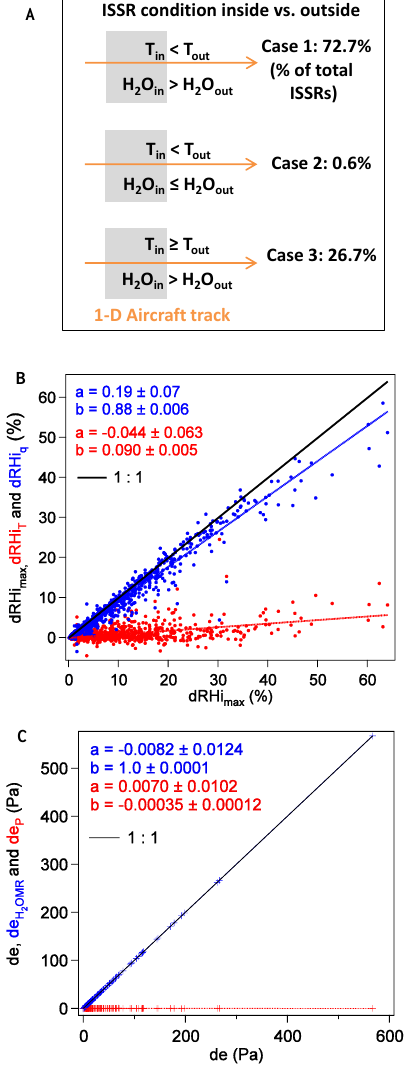
Fig. 7. Correlations between ISSR heterogeneities and T , H 2 O hor- izontal heterogeneities. (A) ISSR locations are correlated with three cases of T and H 2 O spatial heterogeneities. Grey and blank re- gions represent ISSRs and the adjacent horizontal ( dP <1hPa) non- ISSRs, respectively. T in and T out represent the mean T value inside and outside ( ± 1s) ISSRs, respectively, and similarly for H 2 O in and H 2 O out . For 1094 horizontal ISSR segments, 99% of them corre- late with higher H 2 O heterogeneities (cases 1 + 3) and 73% corre- late with lower T heterogeneities (cases 1 + 2). (B) d RHi max is the difference between the RHi max in each ISSR segment and the mean RHi of adjacent ( ± 1s) non-ISSRs. The slope of d RHi max (1 : 1 black line) is 1, which is the linear combination of the fitted slope of T contribution ( d RHi T , red markers; slope: 0.090 ± 0.005) and the fitted slope of H 2 O contribution ( d RHi q , blue markers; slope: 0.88 ± 0.006). (C) Similar to (B) , but decomposes the changes of H 2 O partial pressure term ( de , black 1 : 1 line) into the contribu- tions from the changes in total pressure ( de P , red dots) and contri- butions from the changes of H 2 O volume mixing ratio ( d e H , 2 OMR blue dots). The slope of de is almost all contributed by the fitted slope of de H 2 OMR